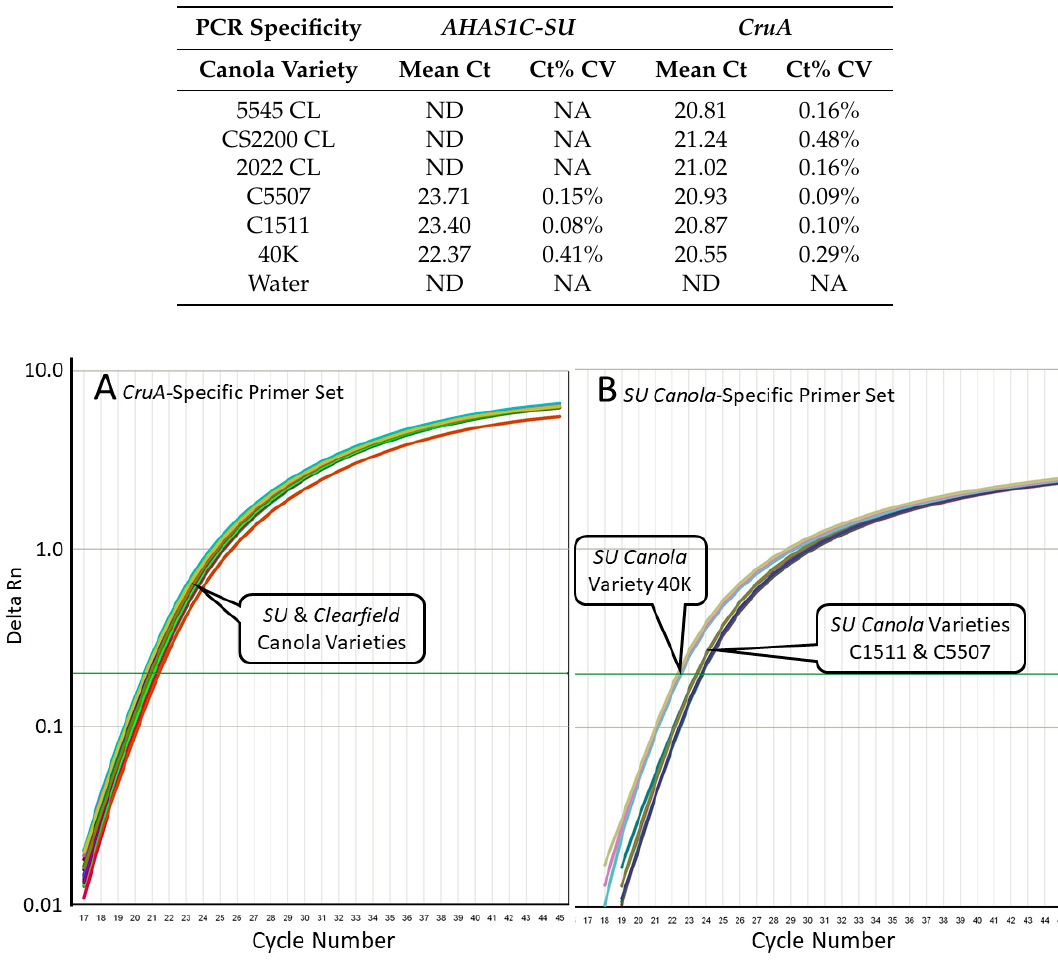
Table 2. Real-time qPCR amplification of SU canola and Clearfield canola DNA with PCR systems specific for the canola endogenous reference gene CruA and for the AHAS1C-SU gene of SU canola. DNA isolated from three SU canola varieties, C1511, C5507, and 40K, and three Clearfield canola varieties, 5545 CL, CS220 CL, and 2022 CL, were tested with primers specific for the AHAS1C-SU gene or for the CruA gene, with 200 ng input DNA per reaction. PCR conditions are as described in Methods. For all conditions except water control, n = 3. ND indicates that no amplification was detected; NA indicates “Not Applicable” because no amplification was observed.